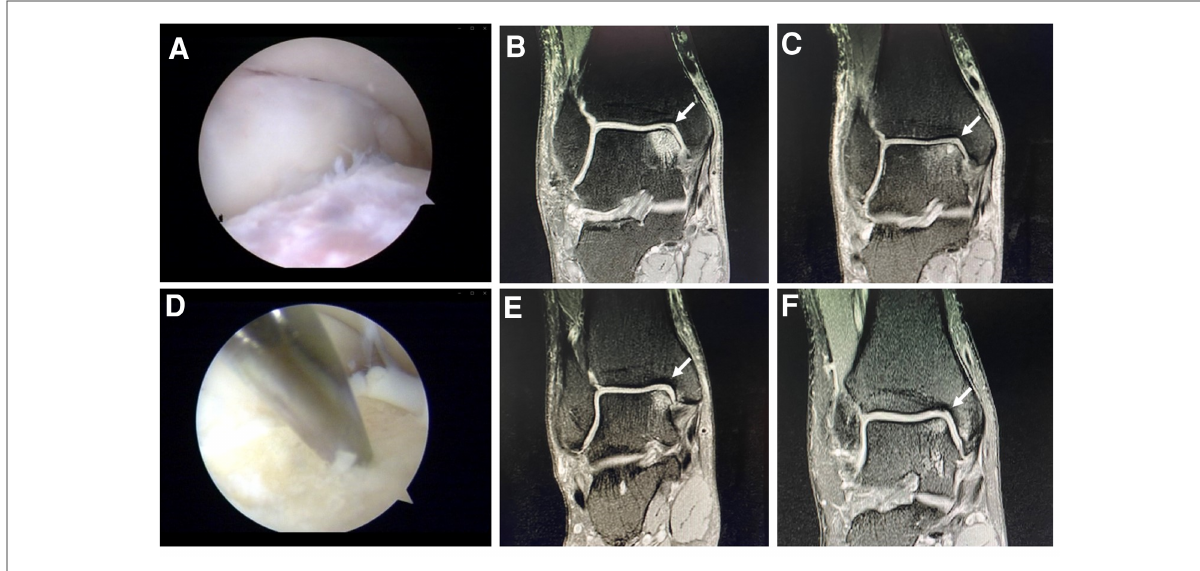
FIGURE 2 Arthroscopic debridement ( A ). Preoperative ( B ) and postoperative ( C ) MRI of a case in the group A. Microfracture ( D ). Preoperative ( E ) and postoperative ( F ) MRI of a case in the group